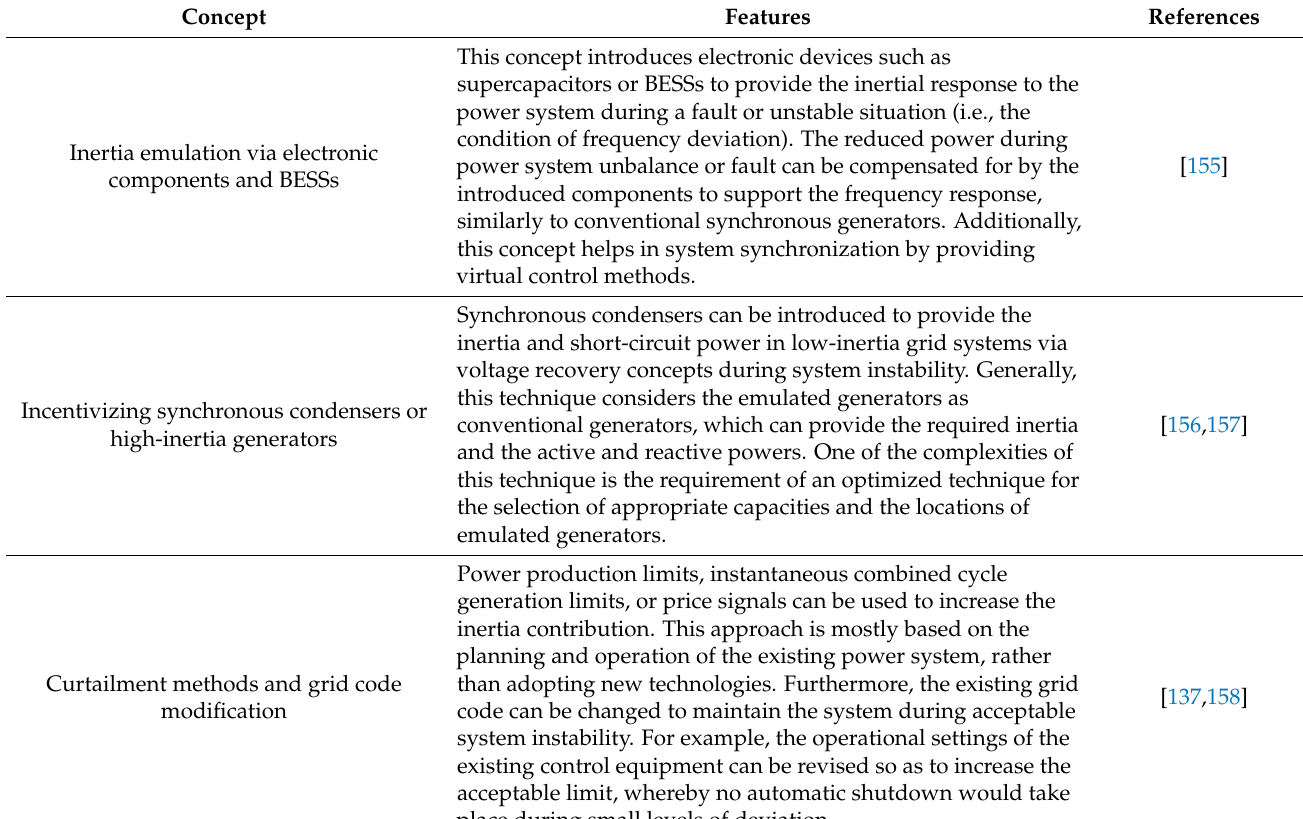
Table 3. List of possible concepts to address the issues occurring in PEC-based power